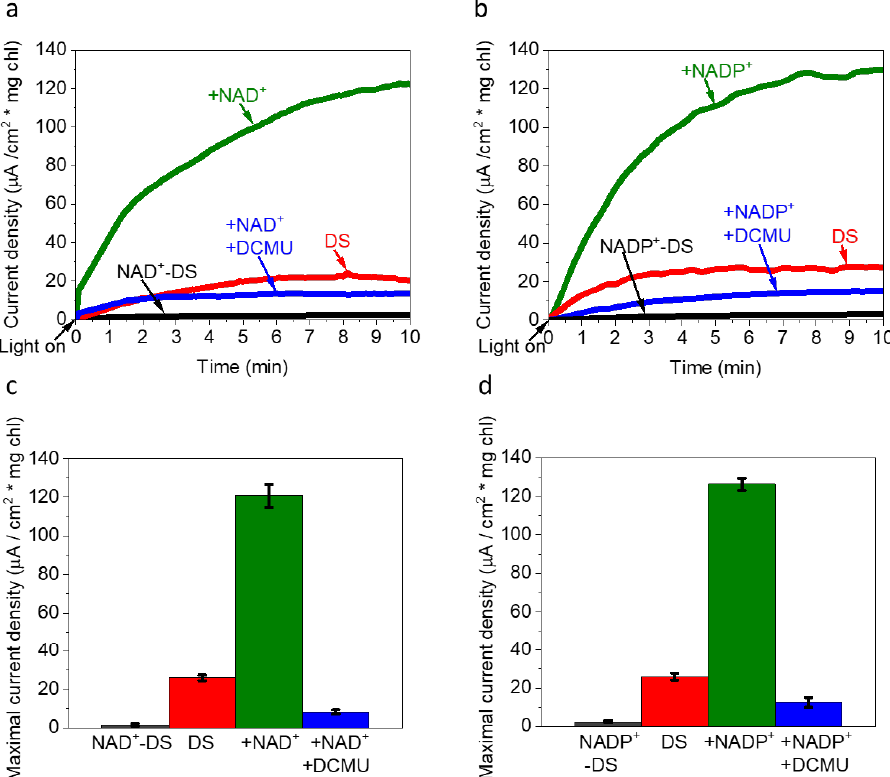
Figure 4. Addition of exogenous NADP + or NAD + enhances the photocurrent production. CA of Ds with addition of NAD + or NADP + and with or without DCMU were measured. ( a ) CA of NAD + (without cells), intact Ds, Ds with addition of NAD + , and with addition of NAD + + DCMU. ( b ) CA of NADP + (without cells), intact Ds, Ds with Addition of NADP + , and with addition of NADP + + DCMU. ( c ) Maximal current densities of the CA measurement that are described in panel a. ( d ) Maximal current densities of the CA measurement that are described in panel b. The error bars represent the standard deviation over three independent measurements. Values obtained in the absence of Ds cells were multiplied by the chlorophyll concentration value used to normalize the samples that contain Ds.